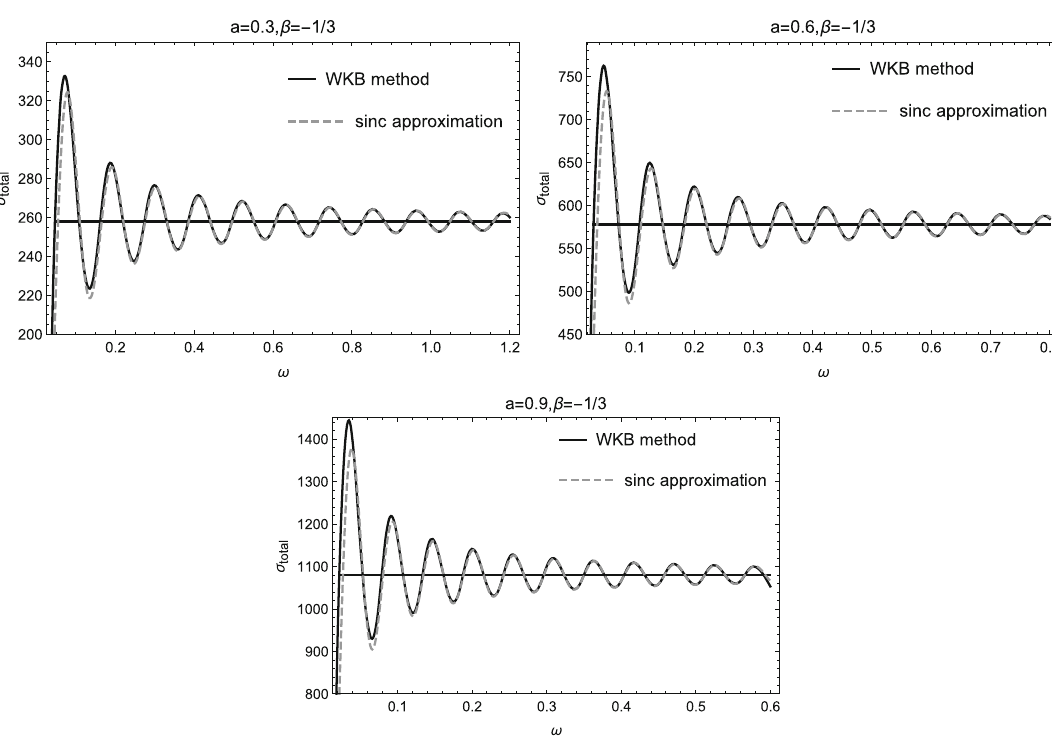
Fig. 8 For β < 0 and M = 1, the total absorption cross section for the variable a with fixed Rastall parameter β = − 1